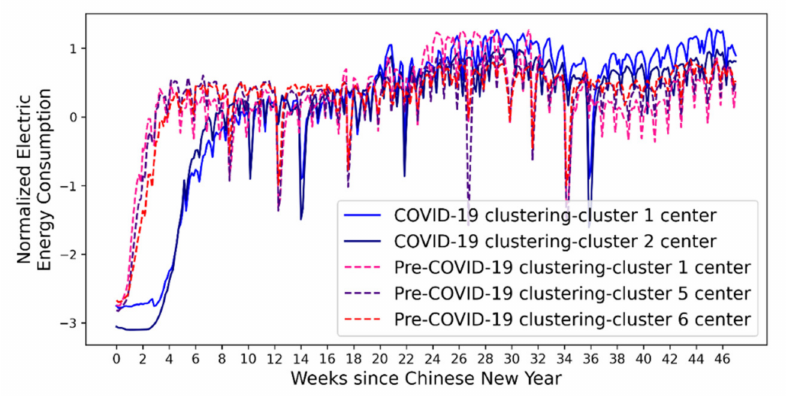
Figure 14. Comparison of the cluster centers between the COVID-19 clustering results and pre- COVID-19 clustering